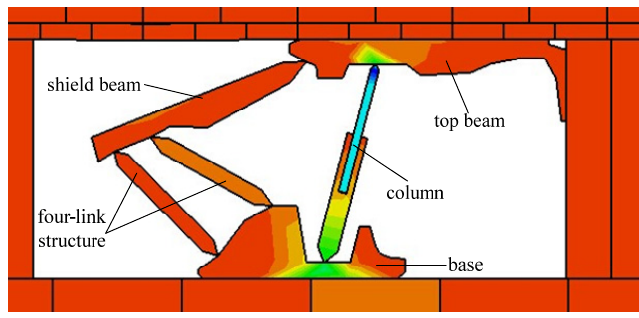
Figure 1. Shield model in numerical simulation.